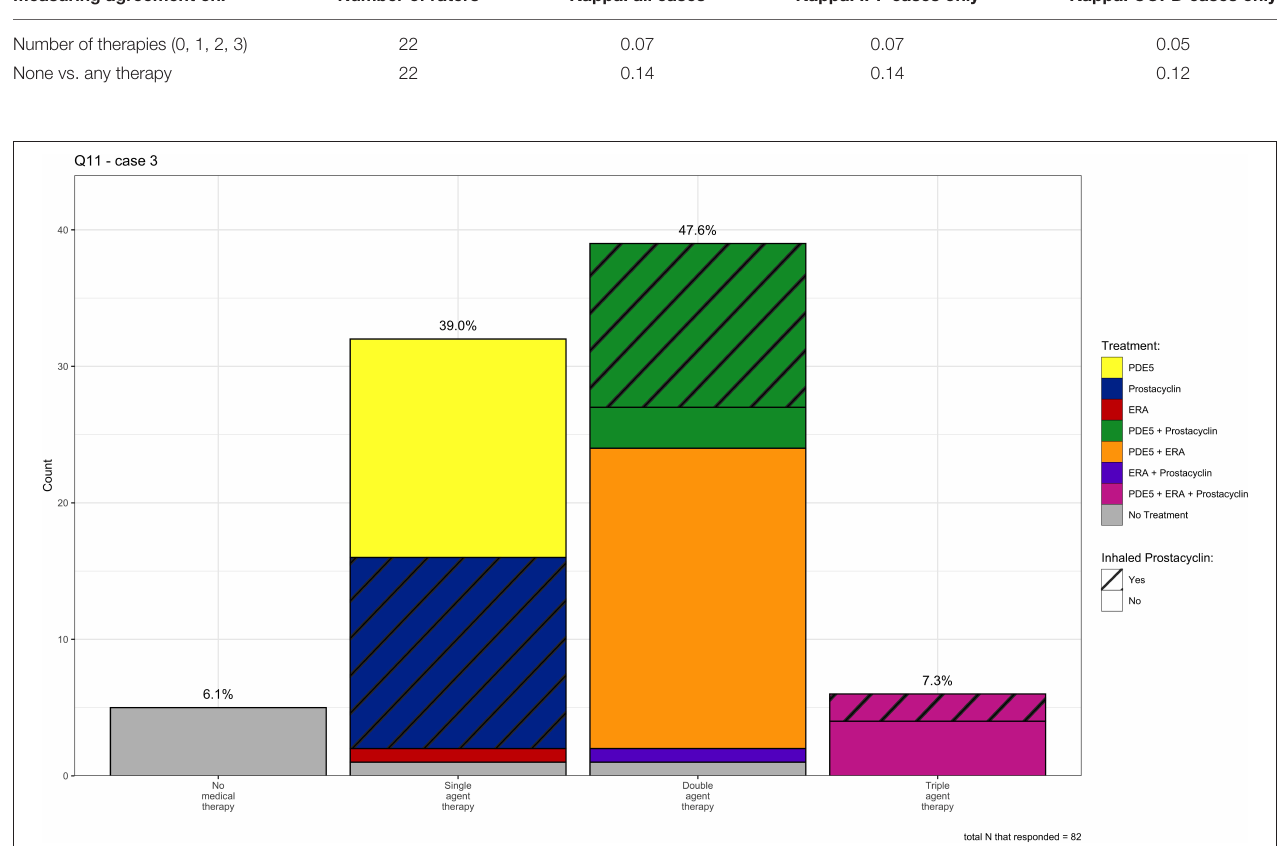
FIGURE 5 | Individual medication choices for case 3 (mild IPF and severe PH), N = 82.